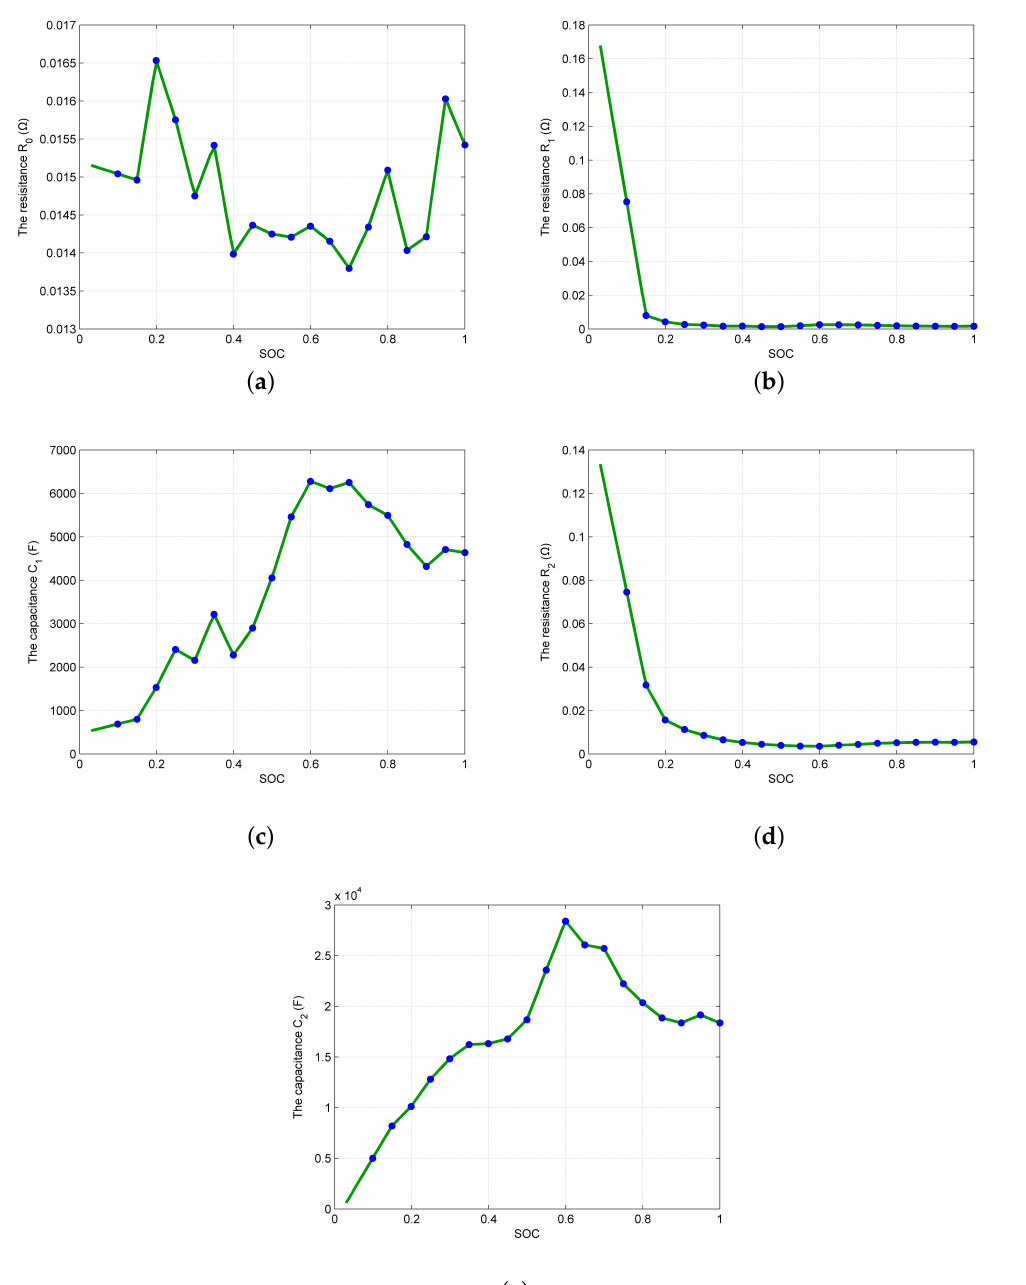
Figure 4. The results of parameter identification. ( a ) The curve of R 0 with respect to SOC; ( b ) The curve of R 1 with respect to SOC; ( c ) The curve of C 1 with respect to SOC; ( d ) The curve of R 2 with respect to SOC; ( e ) The curve of C 2 with respect to